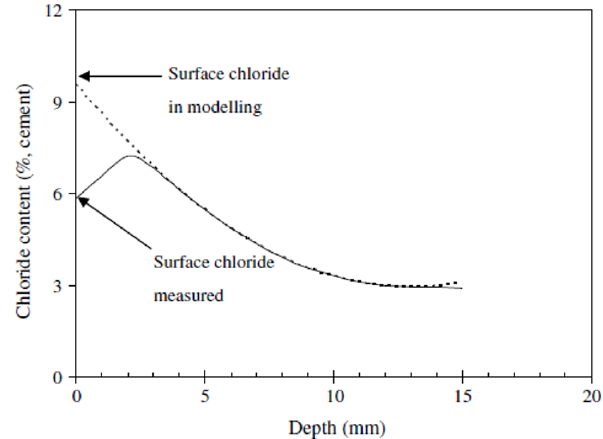
Figure 16. Surface chloride concentration prediction graph (regression) [40].